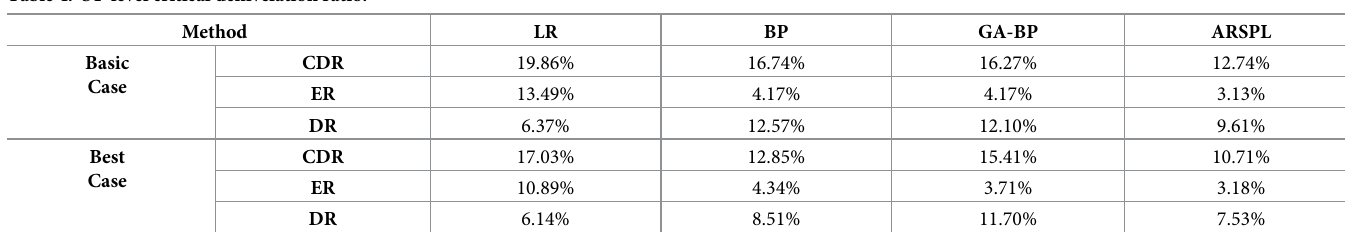
Table 4. ST-level critical denivelation ratio.